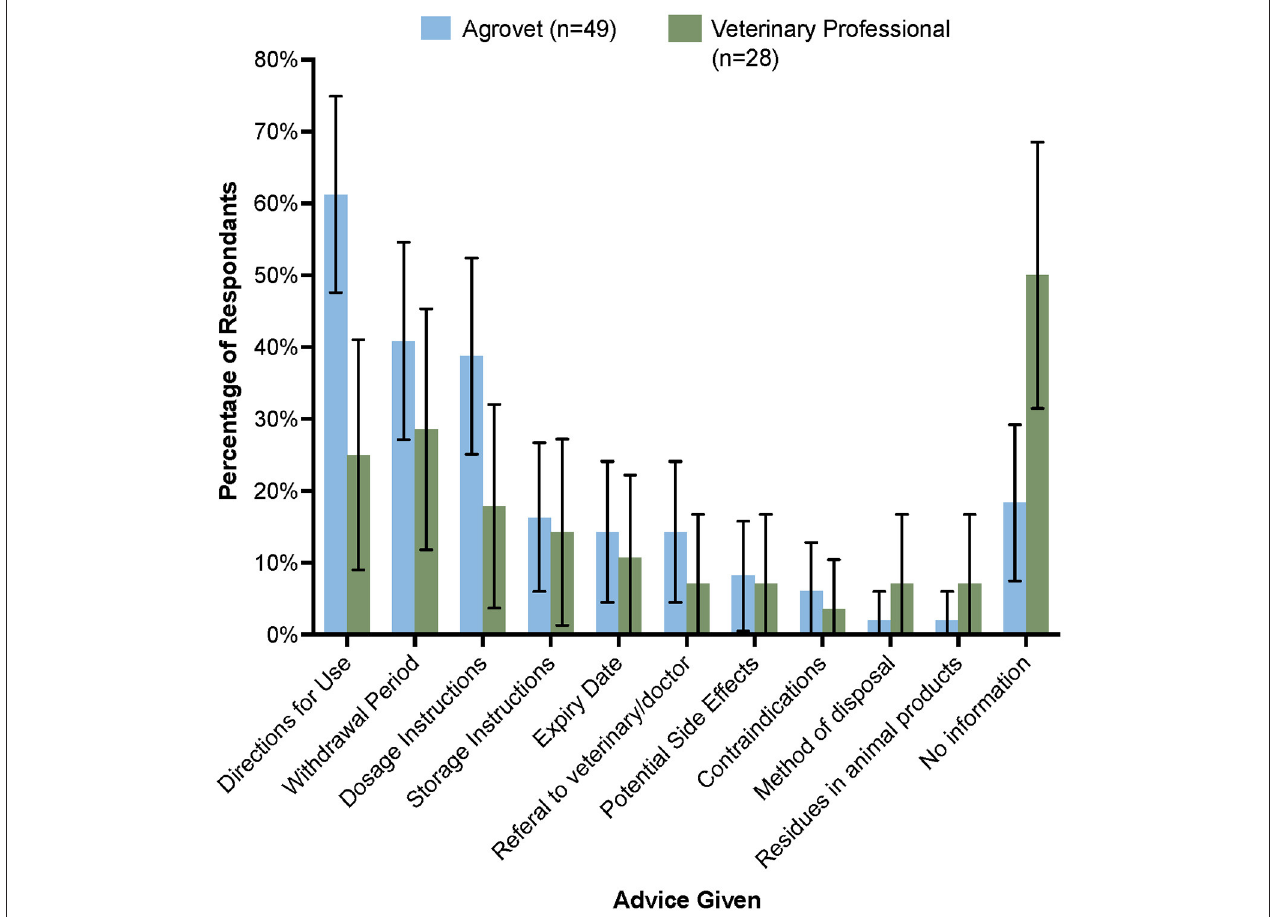
FIGURE 3 | Information given to farmers regarding AMU, AMR, and withdrawal periods at point-of-sale (agrovet shop) or when receiving a prescription (veterinary professional). Error bars represent 95% confidence interval.